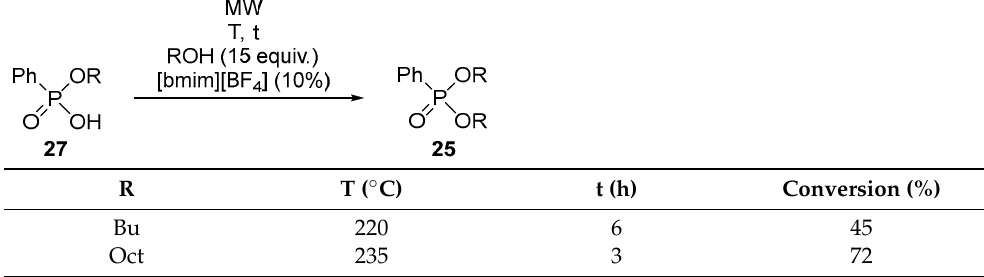
As an alternative possibility, phenylphosphonic acid ( 26 ) was also subjected to alky-